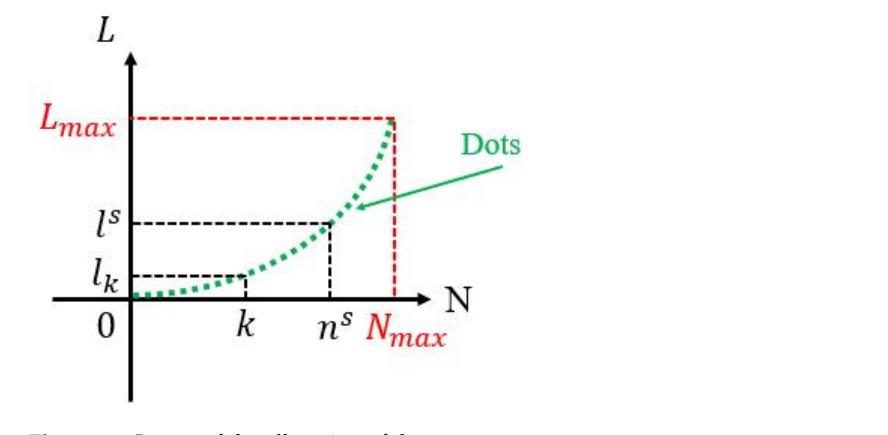
Figure 10. Image of the allocation of